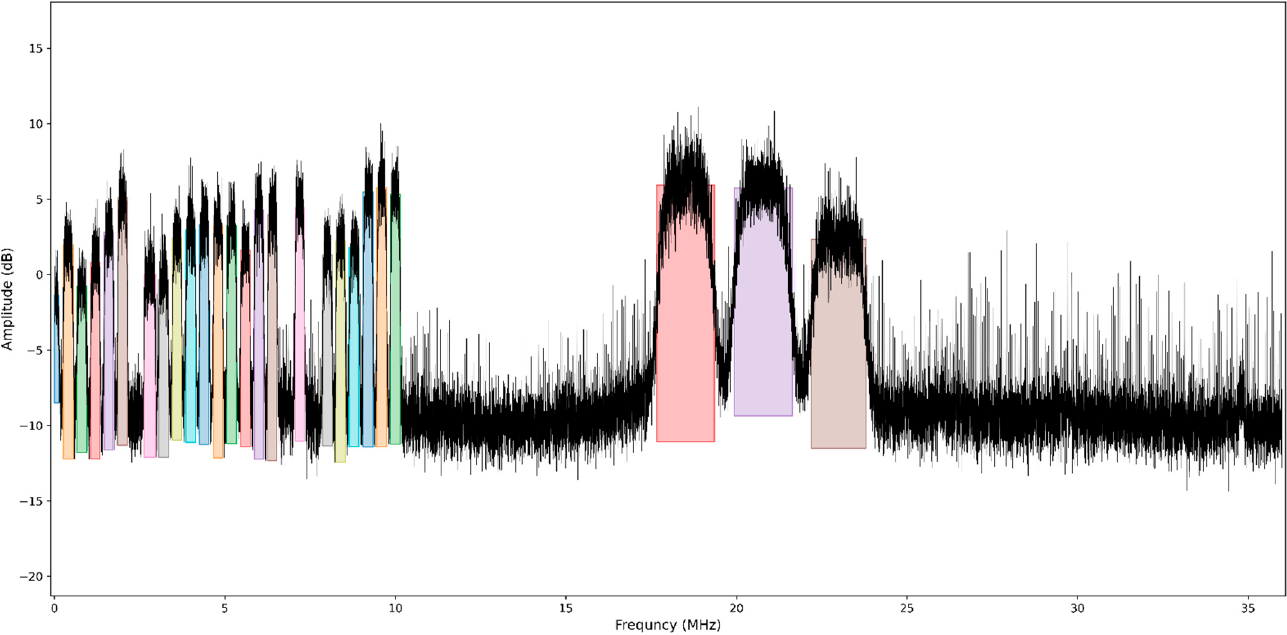
Figure A2. Example2 of the actual satellite broadband power spectrum set.